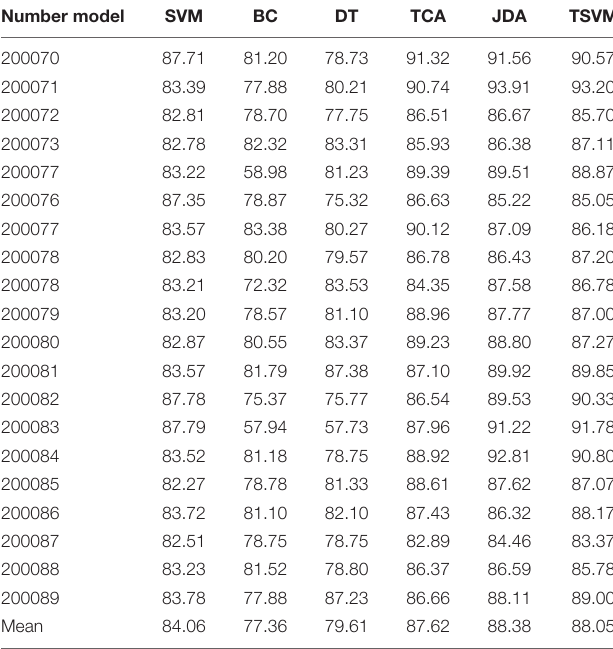
TABLE 5 | TPR indicators of the different classifiers on the test dataset (in